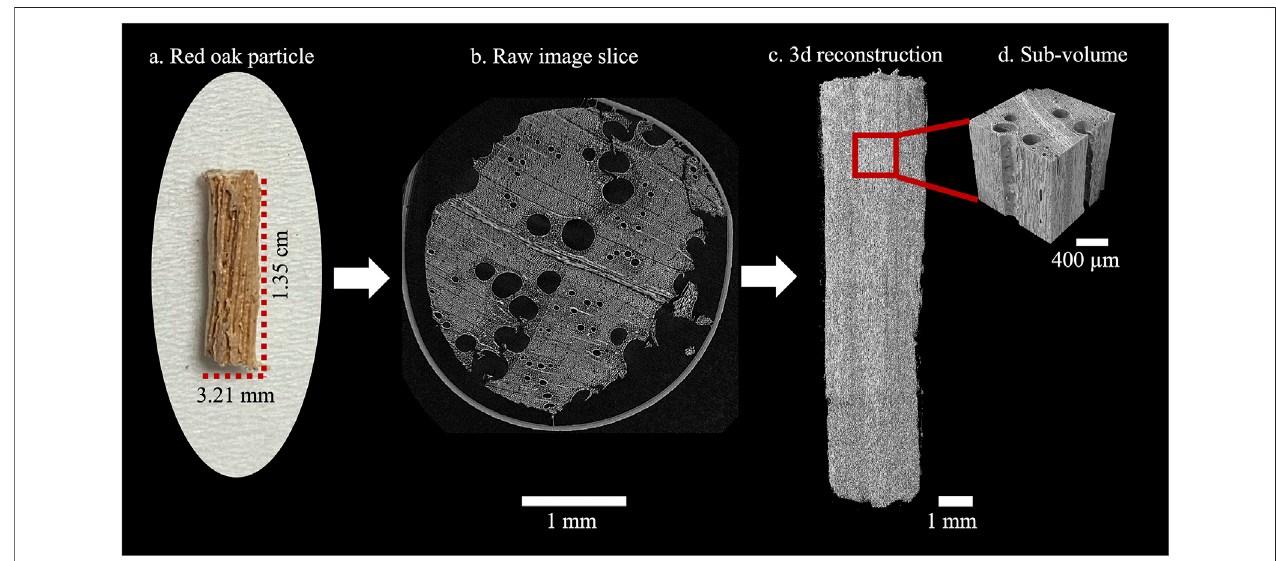
FIGURE 1 | Diagram of XCT work fl ow. (A) Initial particle, native red oak photograph. (B) Raw image slice from XCT radiograph. (C) 3D Reconstruction of the full particle from the raw images. (D) Cropped sub-volume used for numerical analysis and calculation of material